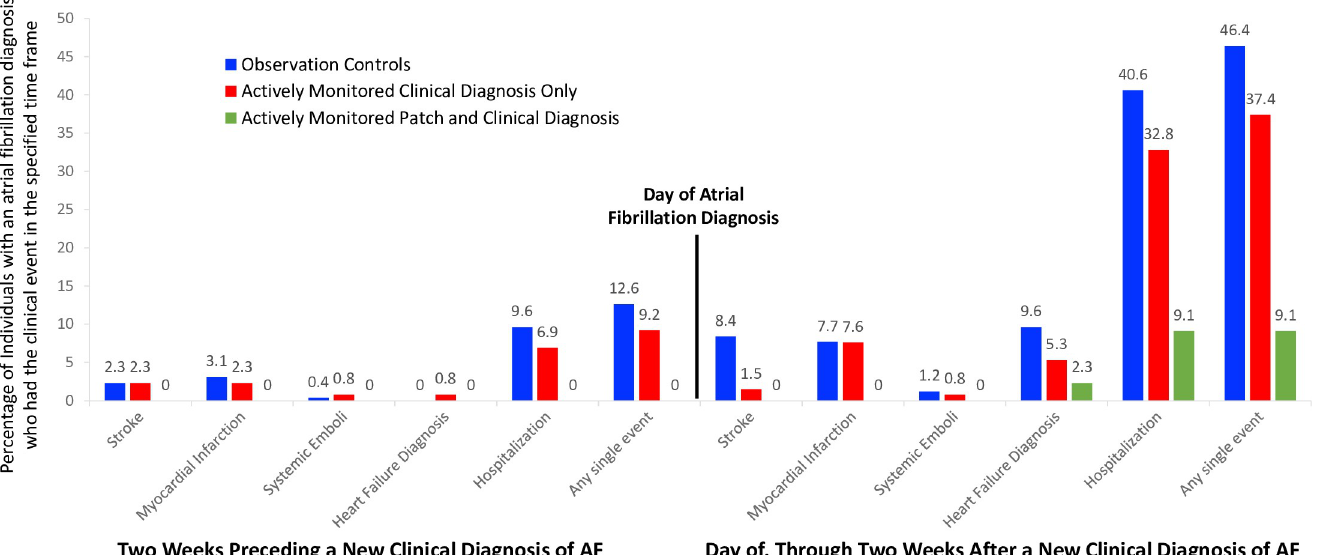
Fig 5. Clinical events surrounding a new atrial fibrillation diagnosis. Clinical Events in the two weeks preceding and the 2 weeks following a new atrial fibrillation (AF) diagnosis, inclusive of the diagnosis date, in the observational cohort and the actively monitored cohort based on whether their initial diagnosis of AF was via ECG patch screening or via a clinical